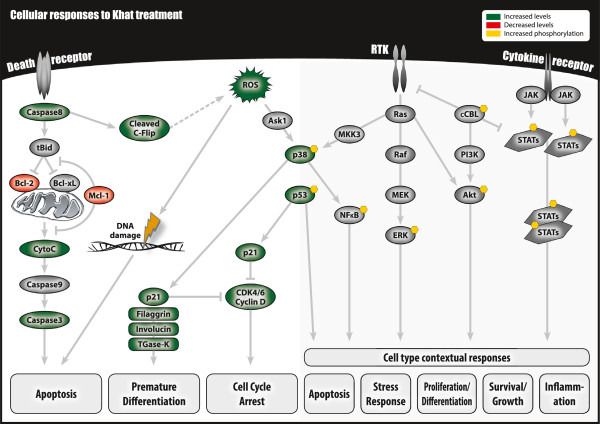
A summary of previous and present findings of cellular effects of khat-extract. Our studies have shown that exposure of various cell types (i.e. leukemic cell lines, normal oral keratinocytes and fibroblasts, normal peripheral leukocytes) to khat-extract in vitro affects various proteins involved in cell death, cell stress, cell cycle regulation, differentiation and cell signaling [26,30,31,33,37].